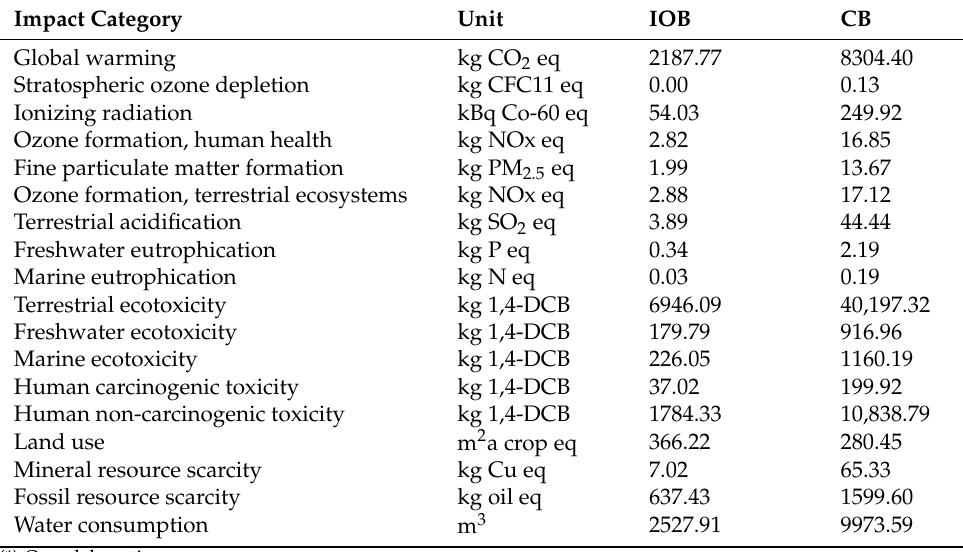
Table 2. Characterisation factors and environmental impact per hectare in innovative organic and conventional broccoli cultivation